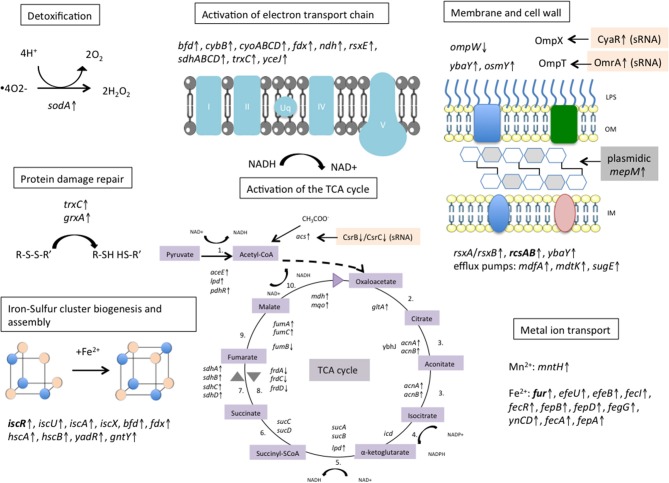
Metabolic response of E. coli pBIC-1a to imipenem exposure. Activation of the electron transport chain pathway dependent on the tricarboxylic acid (TCA) cycle was observed, and is thought to generate ROS according to the model proposed by Kohanski et al. and Dwyer et al. (Kohanski et al., 2007; Dwyer et al., 2014). We observed an up-regulation of most of the TCA cycle enzymes, of many genes involved in Iron–Sulfur cluster biogenesis and assembly, and of several metal ions permeases that are assumed to fuel the Fenton reaction. Detoxification process occured to limit protein damages and ROS accumulation with up-regulation of superoxide dismutase sodA. Several genes involved in bacterial cell wall homeostasis were disturbed. Activation of the plasmidic murein endopeptidase mepM might modify bacterial peptidoglycan and reflect an early activation of bacterial lysis. Transcriptional regulators are written in bold. ↑ means up-regulated and ↓ means down-regulated. LPS, lipopolysaccharide; OM, outer membrane; IM, inner membrane. Reactions of the TCA cycle: 1. Pyruvate dehydrogenase, 2. Citrate synthase, 3. Aconitase, 4. Isocitrate dehydrogenase, 5. α-ketoglutarate dehydrogenase, 6. SuccinylCoA thiokinase, 7.Succinate dehydrogenase, 8. Fumarate reductase 9. Fumarase, 10. Malate dehydrogenase.